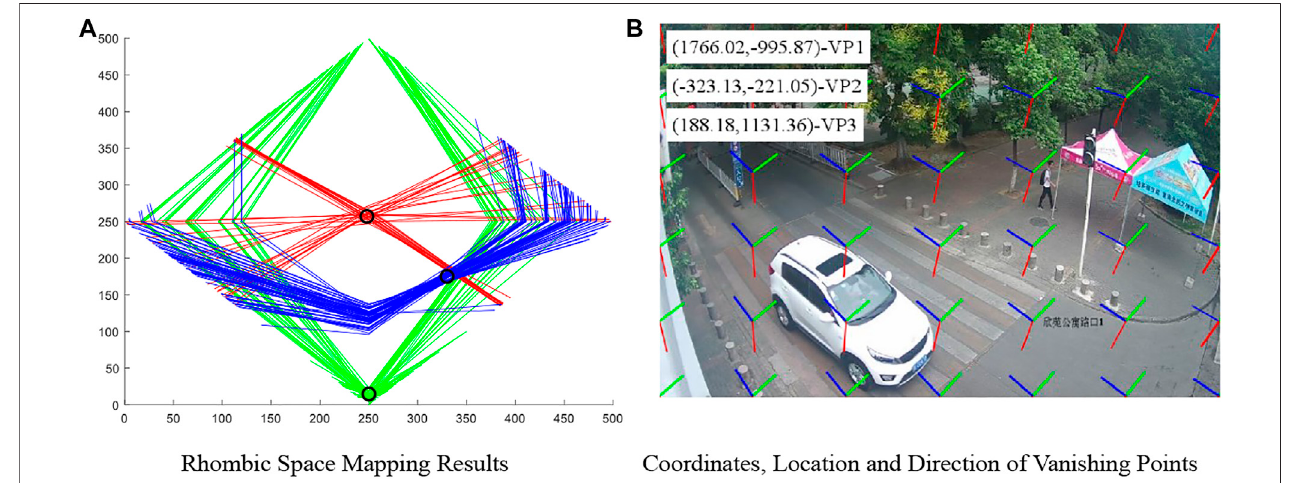
FIGURE 9 | Mapping and coordinate results of rhombic space. (A) Rhombic space mapping results. (B) Coordinates, location, and direction of vanishing